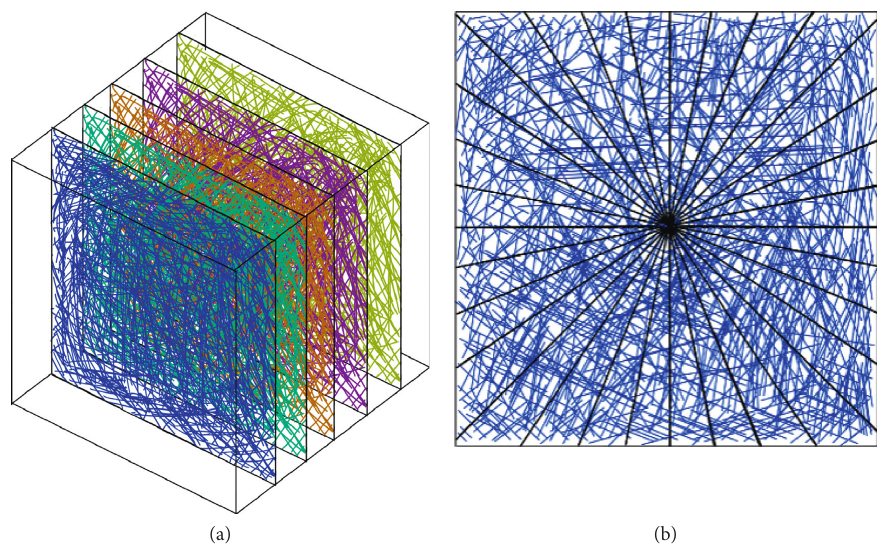
Figure 3: Schematic of scanline and section arrangement: (a) section’s layout and (b) scanline’s